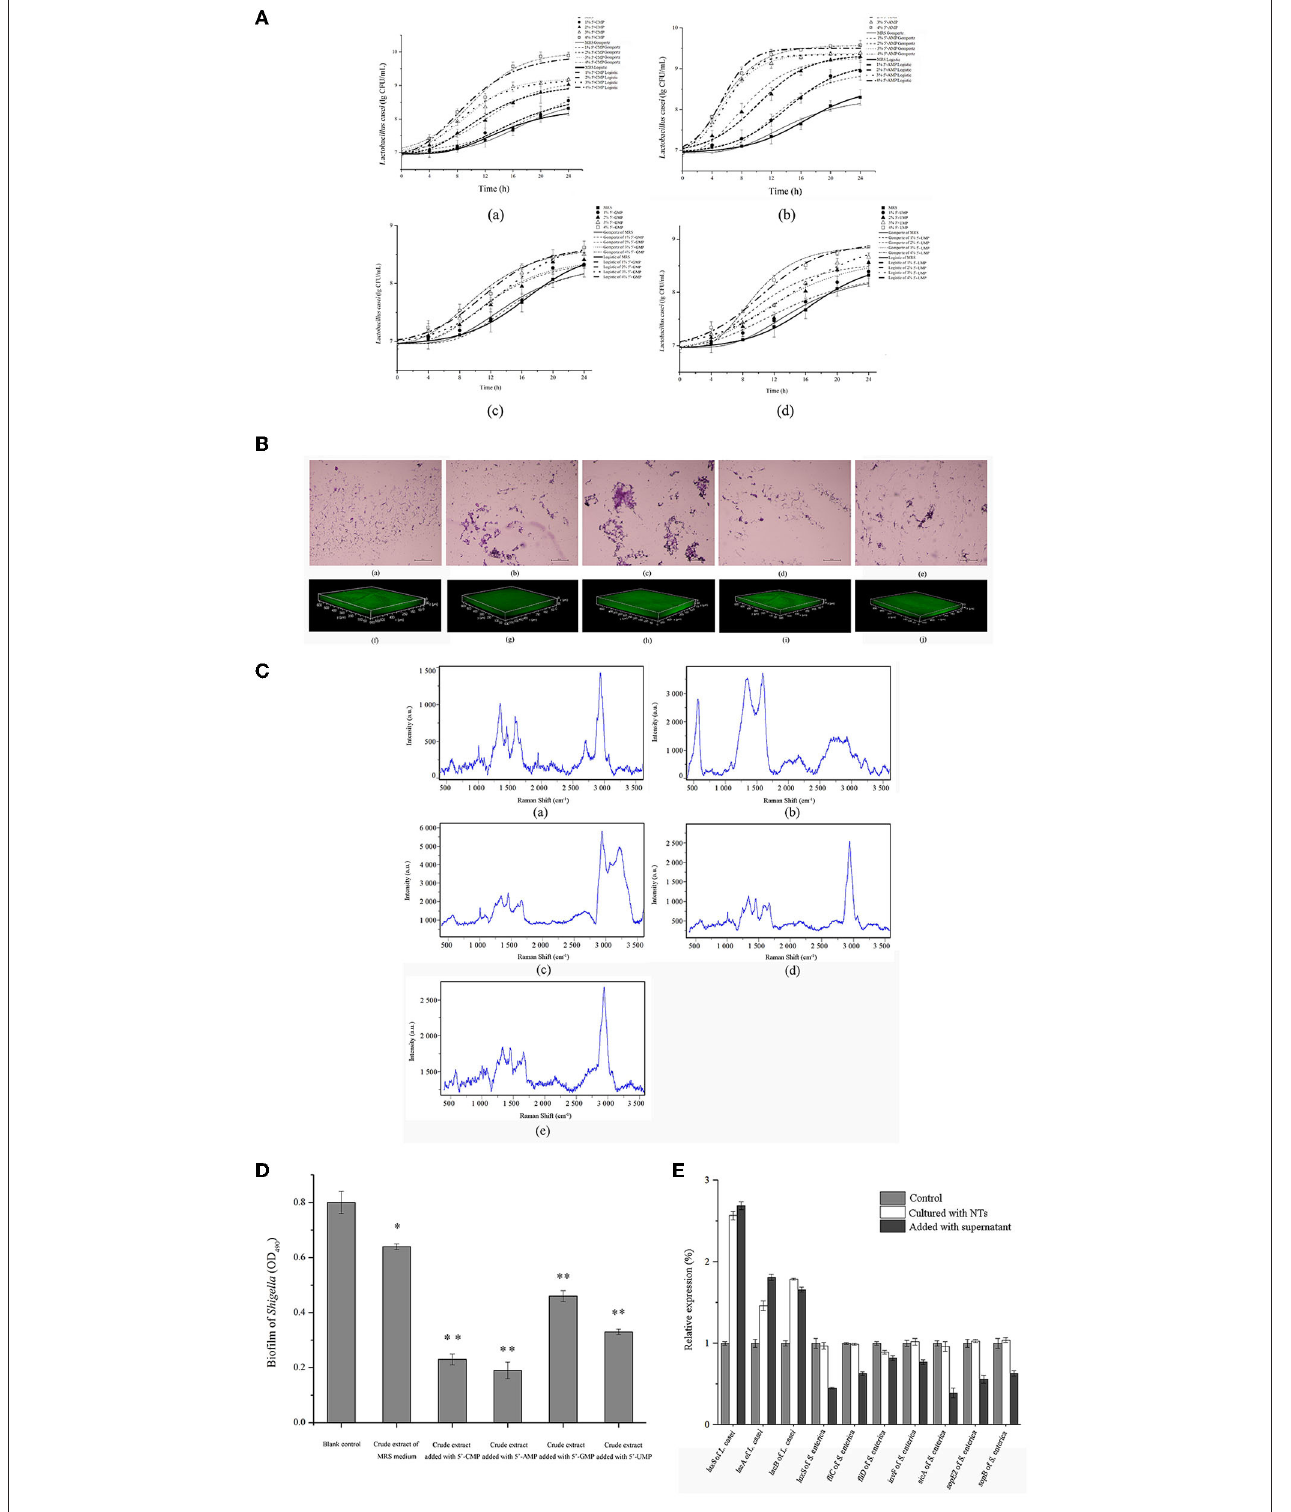
FIGURE 13 | Effects of dietary NTs on the growth of L. casei in vitro. (A) The growth curve of L. casei was fitted by Modified Gompertz and Modified Logistic equation. (a) Addition of 5’-CMP; (b) Addition of 5’-AMP; (c) Addition of 5’-GMPNa 2 ; (d) Addition of 5’-UMPNa 2 . (B) The effect of NTs on the biofilm of L. casei observed by optical microscope (a–e) and CLSM (f–j) . (a, f) Control; (b, g) Addition of 4.0% 5’-CMP; (c, h) Addition of 4.0% 5’-AMP; (d, i) Addition of 4.0% 5’-GMPNa 2 ; (e, j) Addition of 4.0% 5’-UMPNa 2 . (C) Effect of NTs on the content and chemical composition of EPS produced by L. casei. (a) Control; (b) Addition of 5’-CMP; (c) Addition of 5’-AMP; (d) Addition of 5’-GMPNa 2 ; (e) Addition of 5’-UMPNa 2 . (D) Effect of NTs on anti-biofilm activity of crude extracts of L. casei. (E) Results of RT-qPCR. *p < 0.05, **p < 0.001. Frontiers in Nutrition |